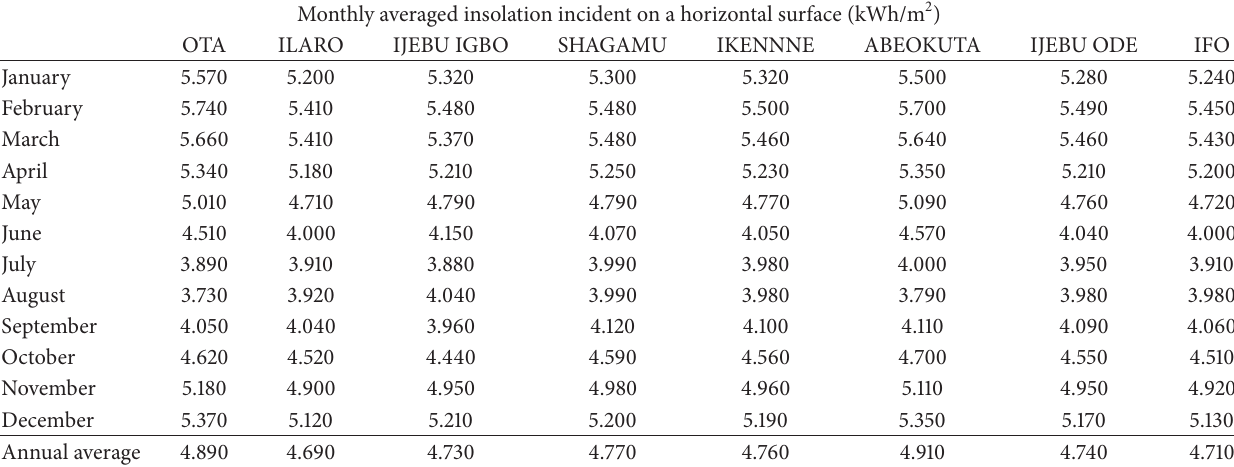
Table 1: Monthly solar insolation for major towns in Ogun State [1].